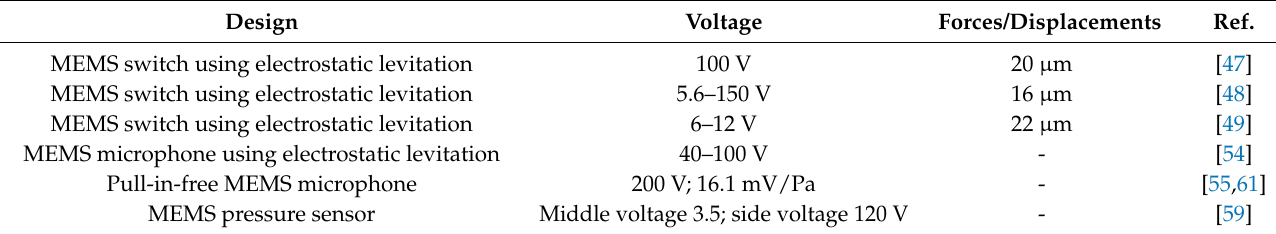
Table 2. Electrostatic levitation actuators reported in the last 5 years.